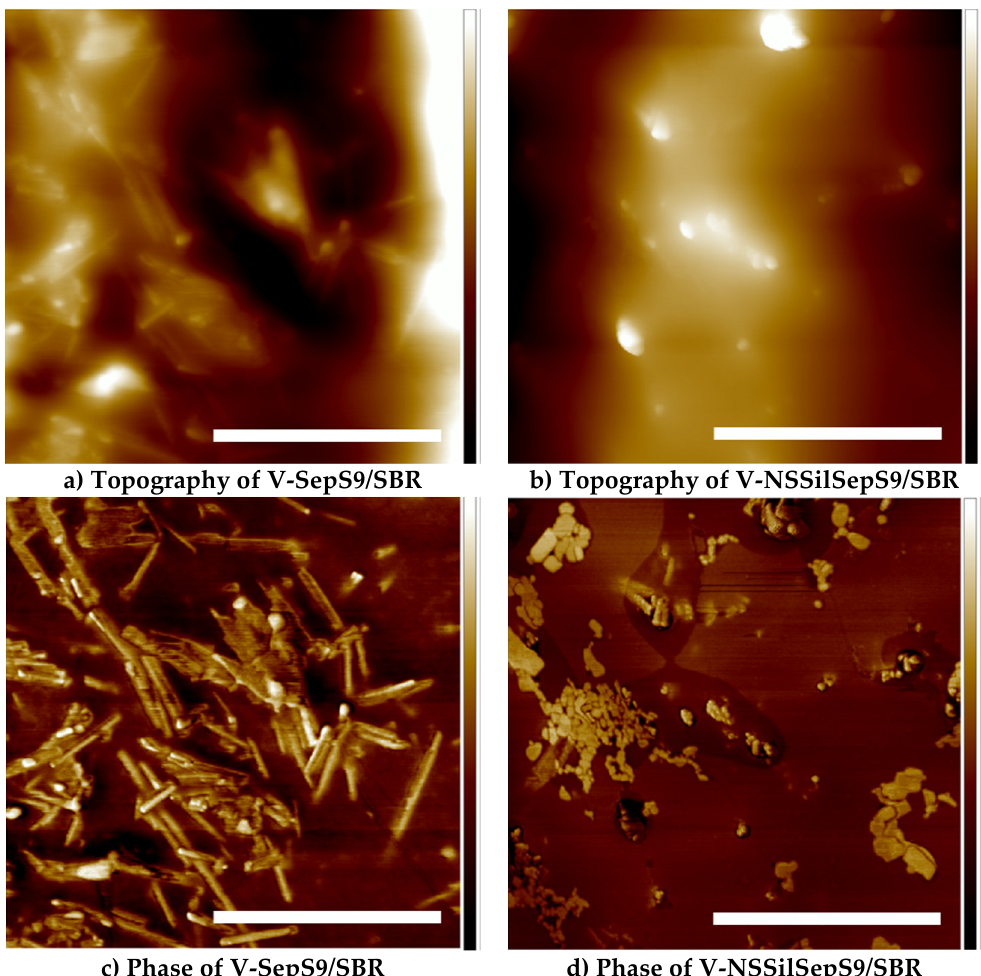
Figure 8. TM topographic and phase images of the cured composites: ( a , c ) V-SepS9/SBR and ( b , d ) V-NS-SilSepS9/SBR. The white scale bar is 1.0 μm. The Z-range is 100 nm and the phase scale is 25 degrees.